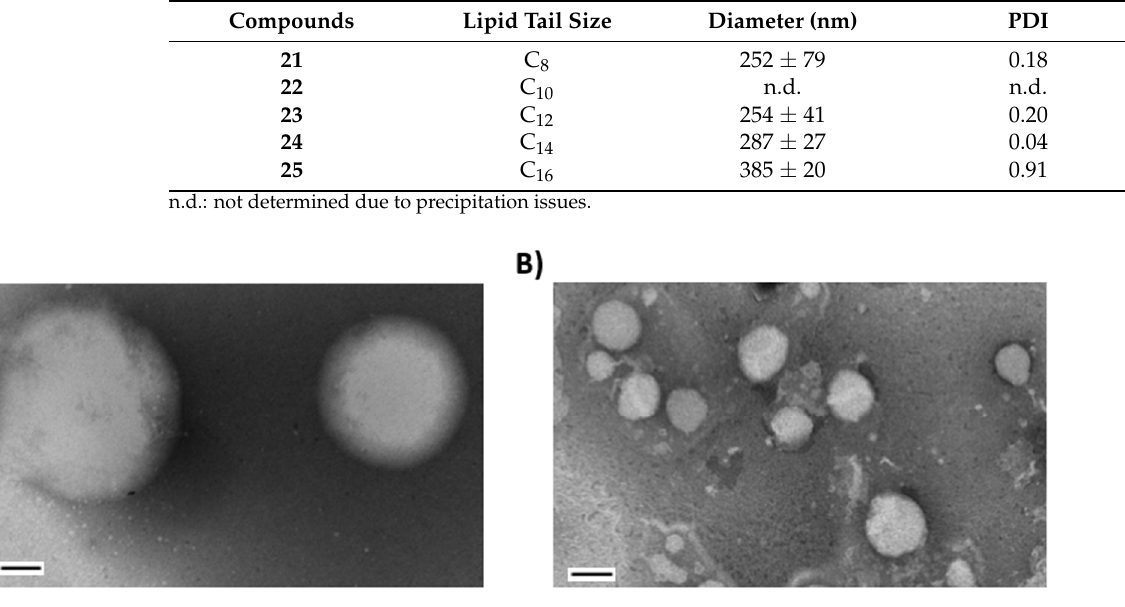
Figure 2. Transmission electron micrographs (TEM) of ( A ) ML-C 12 and ( B ) 24 . Solutions of the glycolipids (0.5 μ g/uL in ddH 2 O) were analyzed after incubation at room temperature for 24 h. The preparation was negatively stained with 3% phosphotungstic acid and imaging performed at 75 kV. Bar = 100 nm.